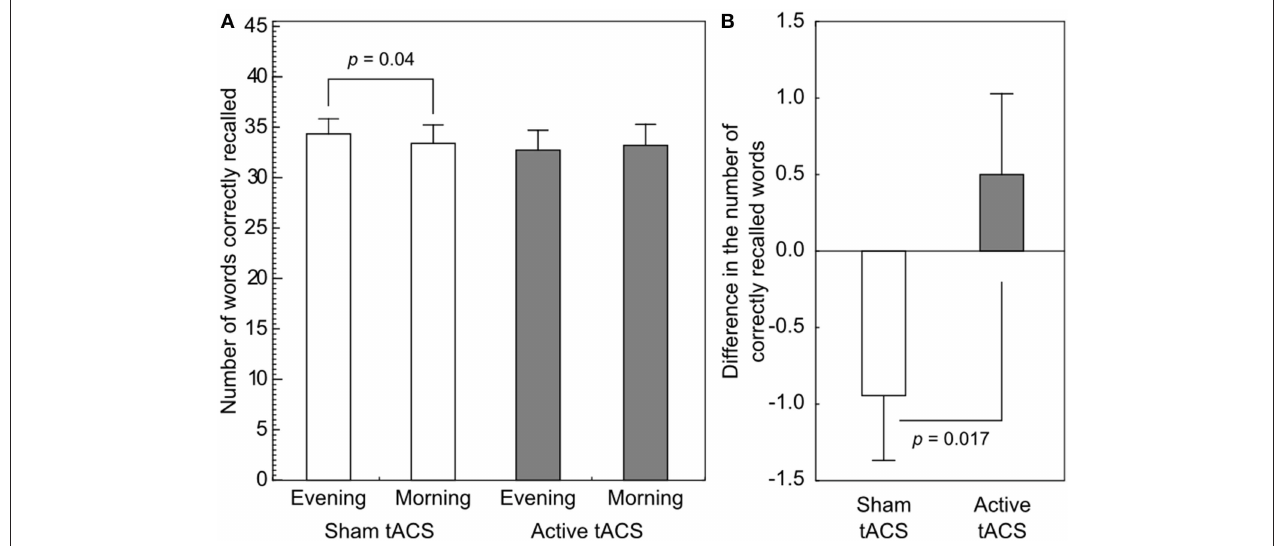
FIGURE 2 | Performance on the associative word-pair learning task. (A) A paired t -test revealed a significant difference in performance in the sham stimulation condition, indicating forgetting. No such difference could be observed in the active stimulation condition. (B) The difference in the number of correctly recalled words from evening to morning was shown to be significantly different between the stimulation conditions. Error bars denote SEM.